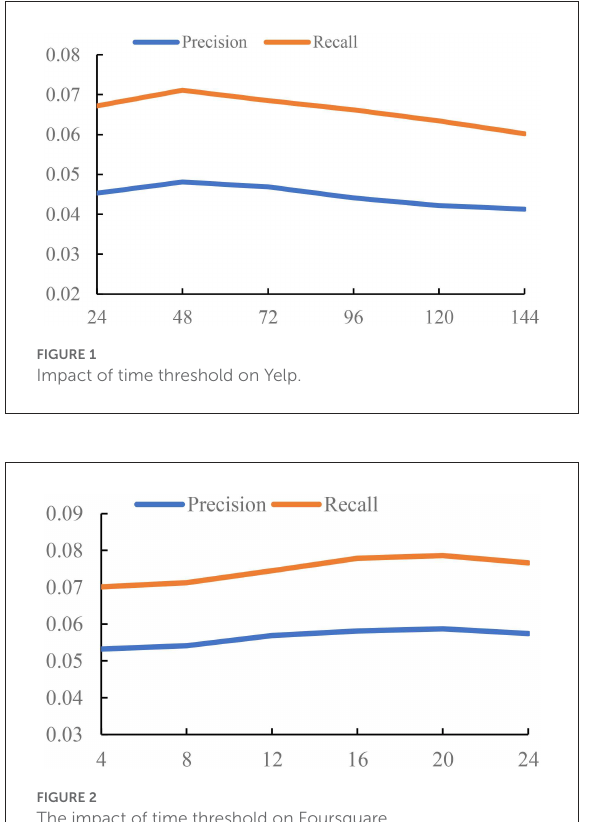
TABLE 3 Results of all methods on